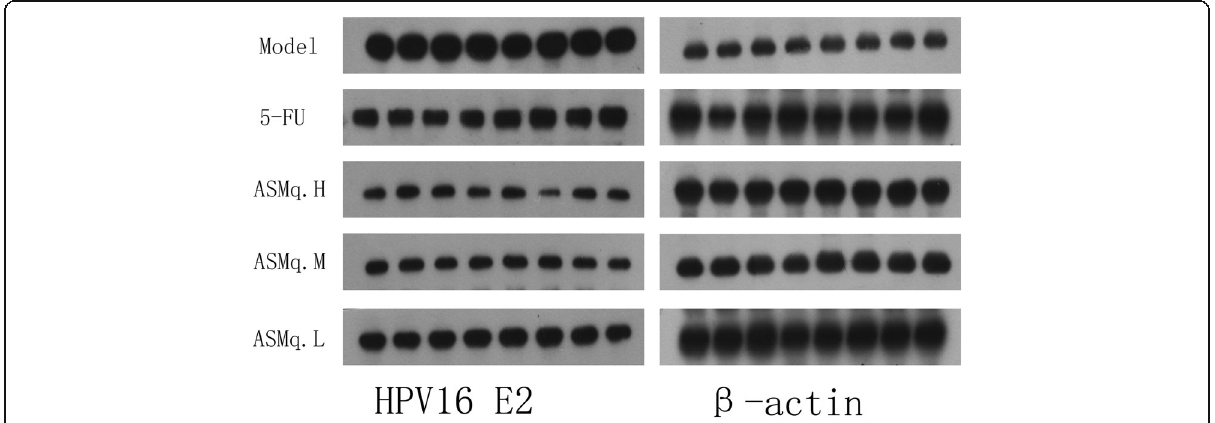
Fig. 3 The effects of 5-FU combined with Abnormal Savda Munziq on the protein expression of HPV16 E2 in mice bearing U27 cell-induced tumors